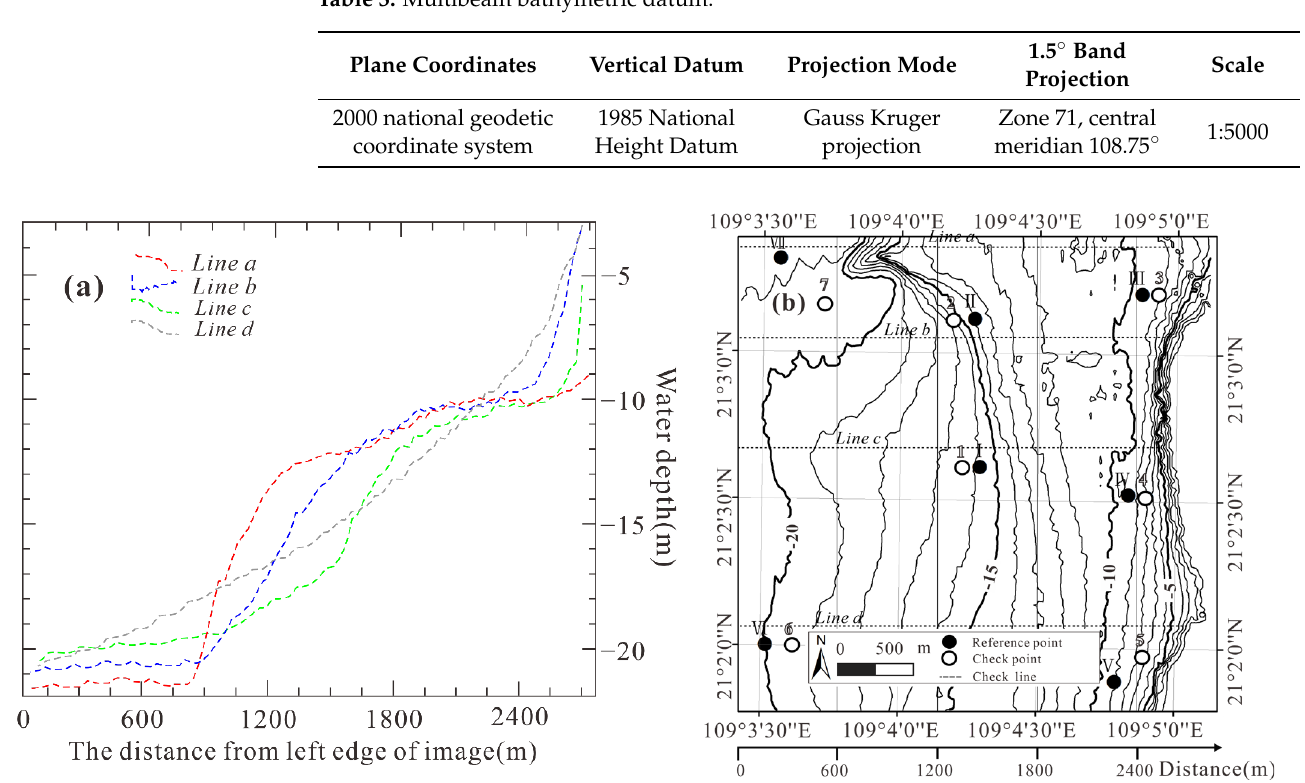
Table 4. Measurement accuracy.